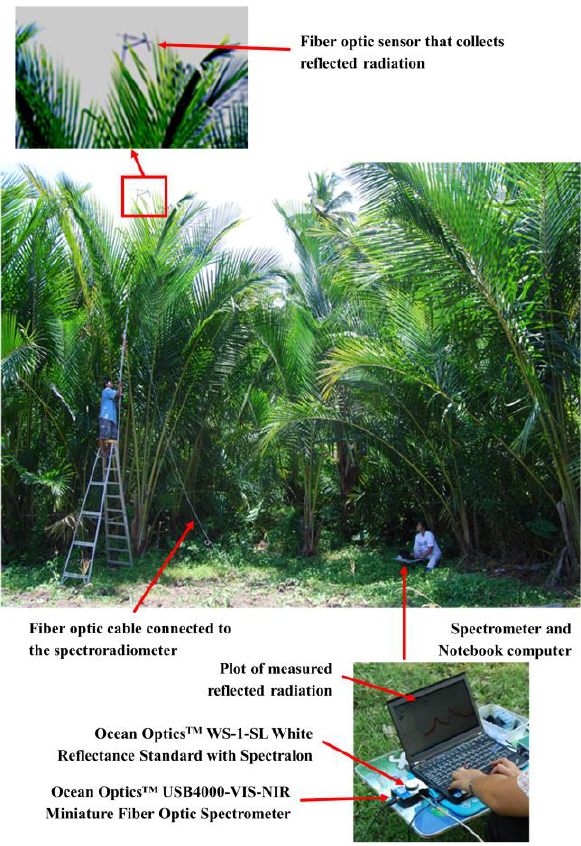
Figure 2. In-situ spectral reflectance measurement